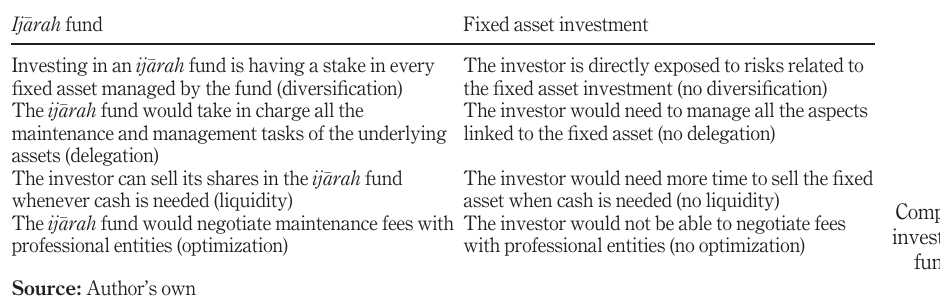
Table 2. Comparison